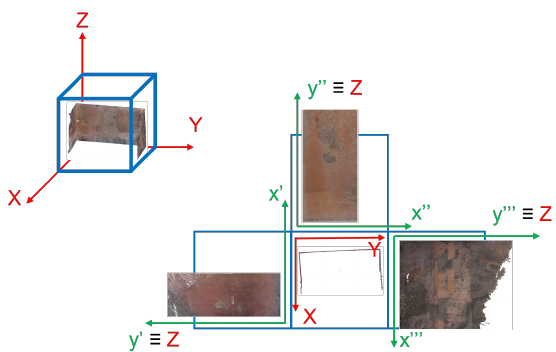
Figure 7. Developing of 3D virtual model of the walls into three 2D